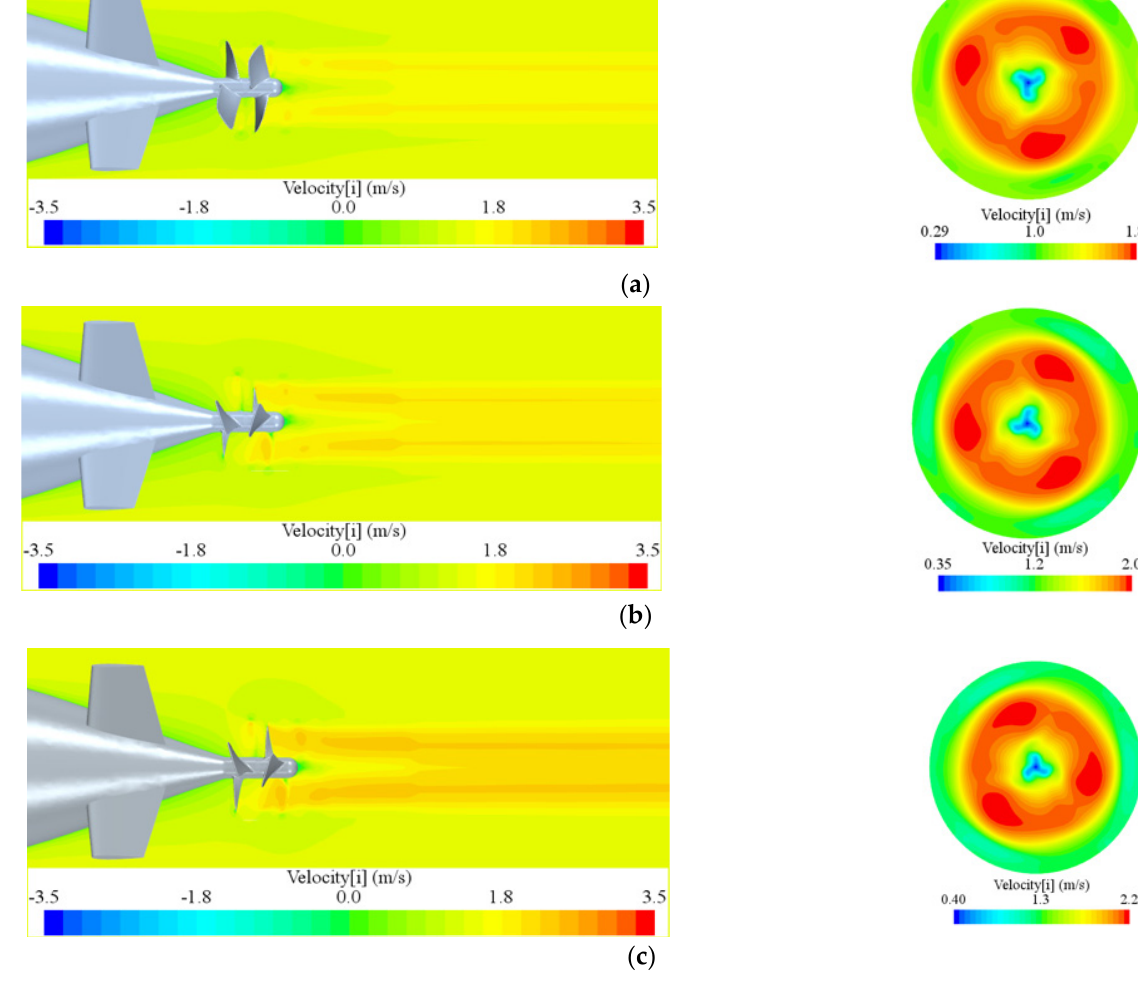
Figure 31. Velocity distribution of the hybrid-driven AUG with the CRP at rotation speeds of 720 rpm ( a ), 800 rpm ( b ), and 900 rpm ( c ) including the sideview of the wake and the axial velocity plane 0.085 D a downstream of the rear propeller disk.